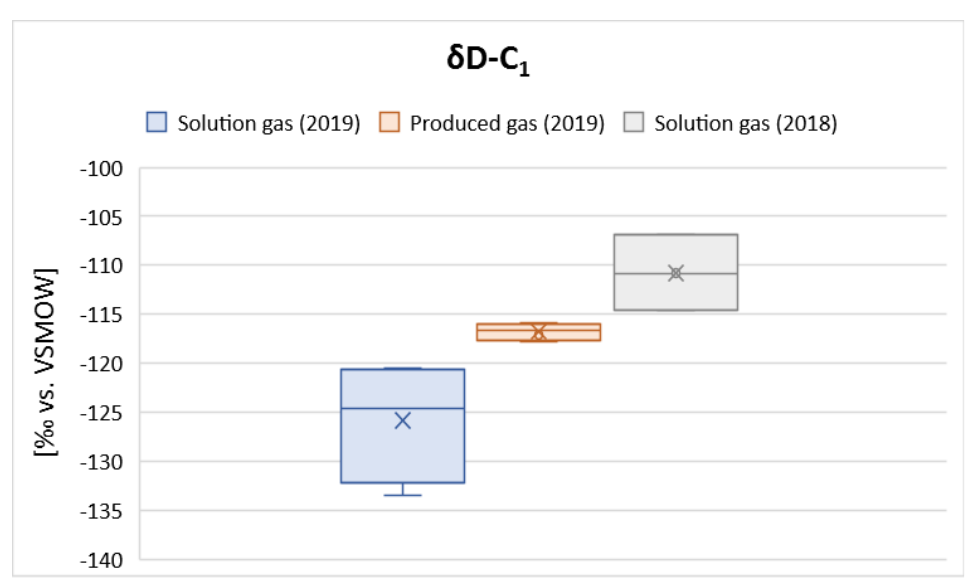
Figure 7. Variability of the isotope composition of hydrogen in methane.